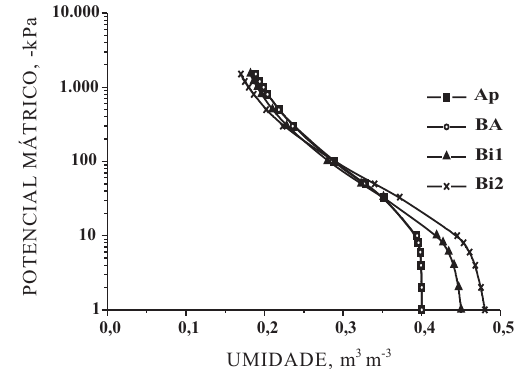
Figura 1. Curvas características de umidade do Cambissolo Háplico Ta eutrófico